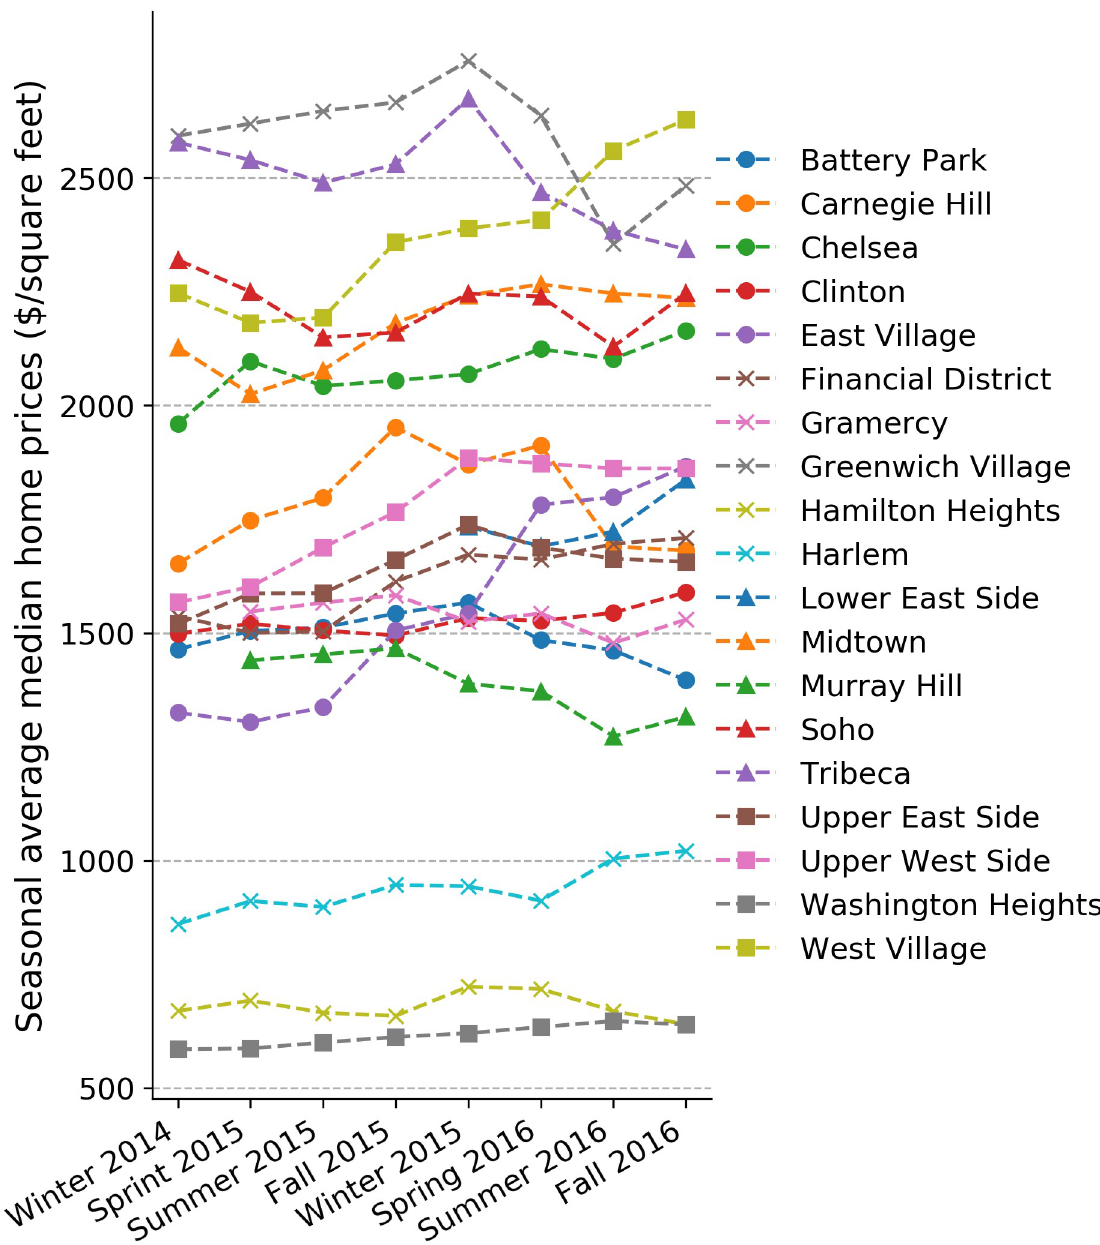
Fig 7. Unit home price (UHP) ($/ ft 2 ) changes—Seasonal average 12/2014–11/2016.